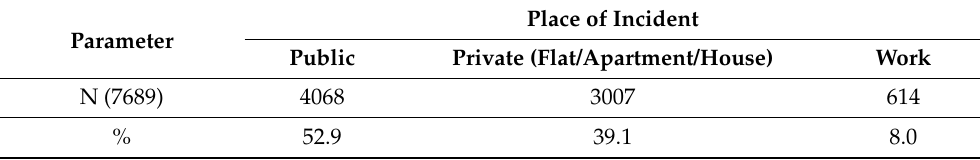
Table 6. Division of incidents by